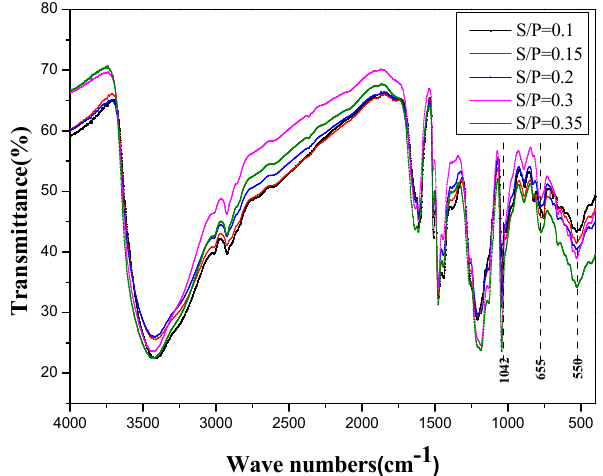
Figure 10. Effects of S/P on the SPF resin properties (mean ± s.d., n = 3 per condition). In order to investigate the structural changes that occurred between the samples with different S/P values, the FTIR spectra of the samples obtained after freeze-drying under vacuum were recorded, as shown in Figure 11. The FTIR spectra revealed that there were obvious differences in the adsorptions at 1042, 655, and 550 cm − 1 . The adsorption at 1042 cm − 1 was a characteristic absorption value for a sulfonic group. The adsorption at 655 cm − 1 was assigned to the C-S stretching vibration, and the adsorption at 650 cm − 1 was mainly attributed to the S-O stretching vibration of a sulfonic group. It is clear that the adsorption values at 1042, 655, and 550 cm − 1 all increased with the S/P, indicating that the SPF resin can be successfully sulfonated by sodium formaldehyde sulfoxylate.